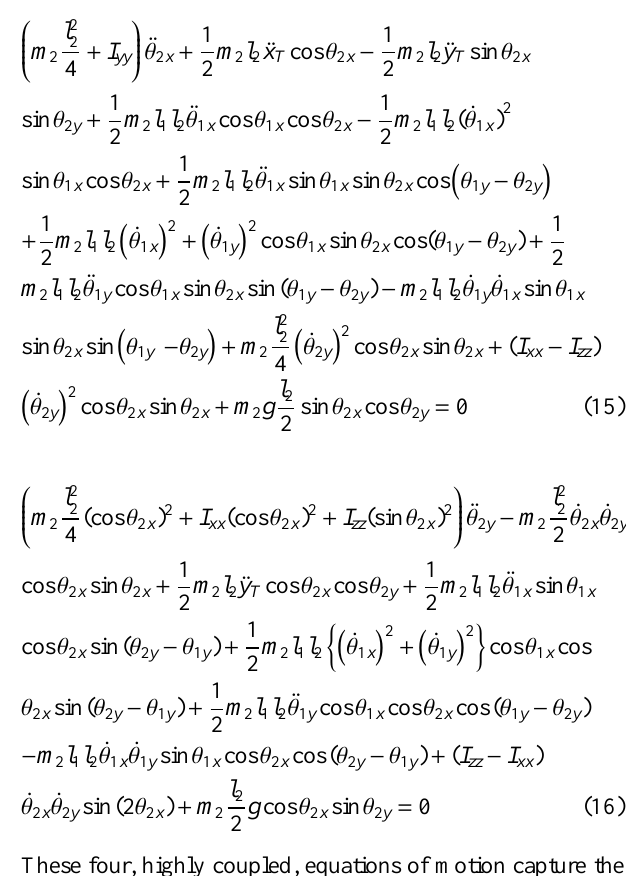
Table 1. Values chosen for the 3-D double pendulum